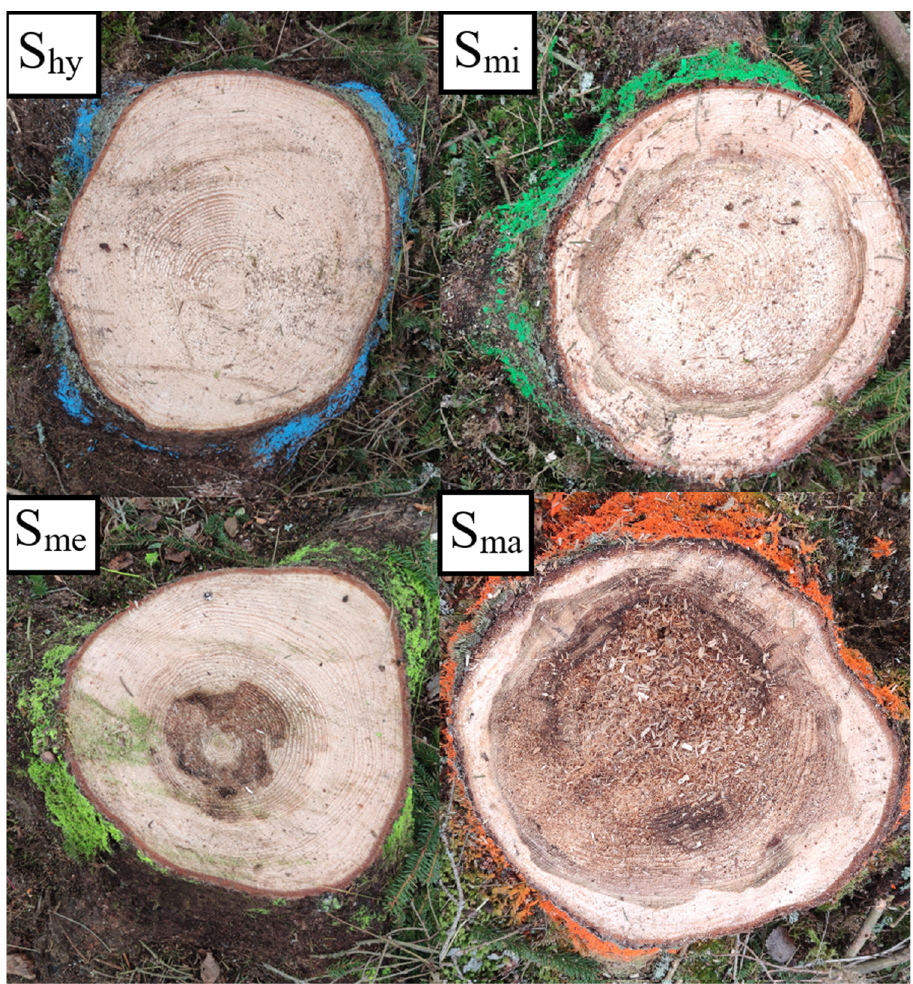
Figure 3. Examples of stump assessment classes (healthy sample tree stump S hy ; sample tree stump with minor defect S mi ; sample tree stump with medium defect S me ; and sample tree stump with major defect S ma ).